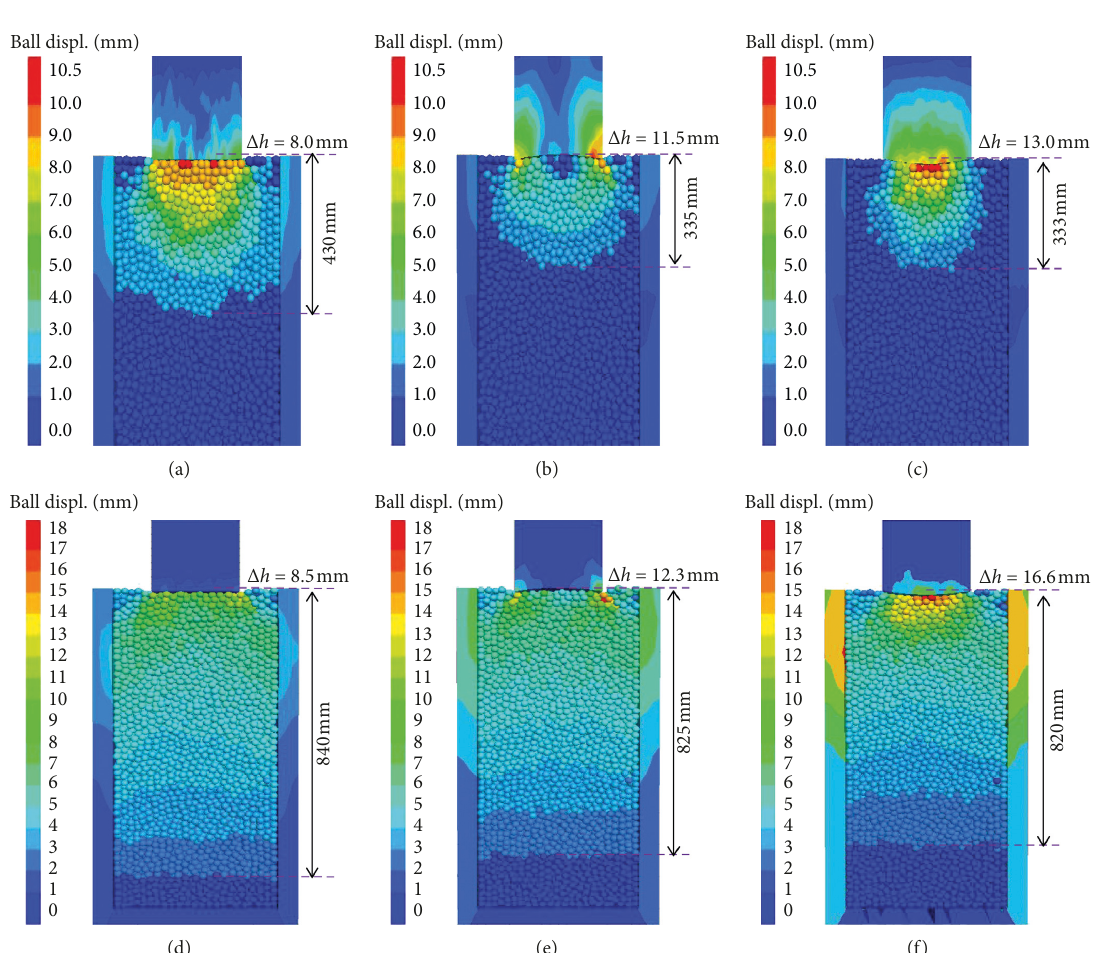
Figure 5: Particle displacement punched by (a) flat-bottomed hammer, (b) concave-bottomed hammer, and (c) convex-bottomed hammer at 3.7 ms and particle displacement punched by (d) flat-bottomed hammer, (e) concave-bottomed hammer, and (f) convex-bottomed hammer at 15ms (the upper parts of hammers are truncated in this